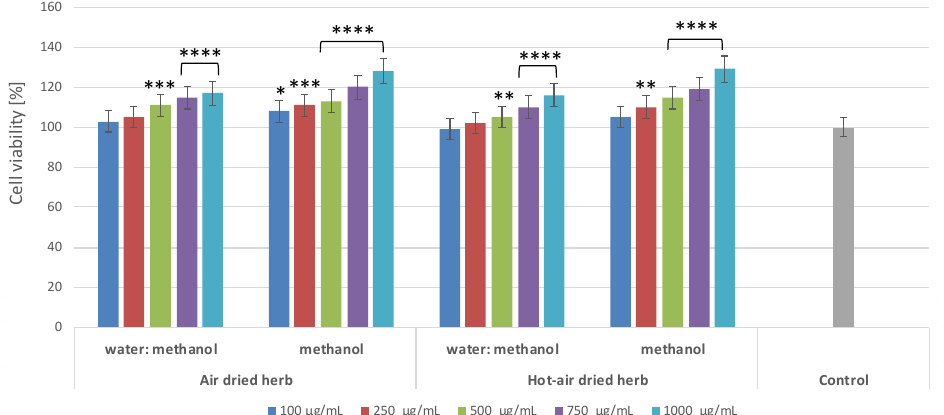
Figure 2. Reduction of resazurin after exposure to B. officinalis extracts in cultured HaCaT cells. Data are the means ± SD of three independent experiments, each consisting of three replicates per treatment group. * p = 0.033, ** p < 0.01, *** p < 0.001, **** p < 0.0001 versus the control (100%).